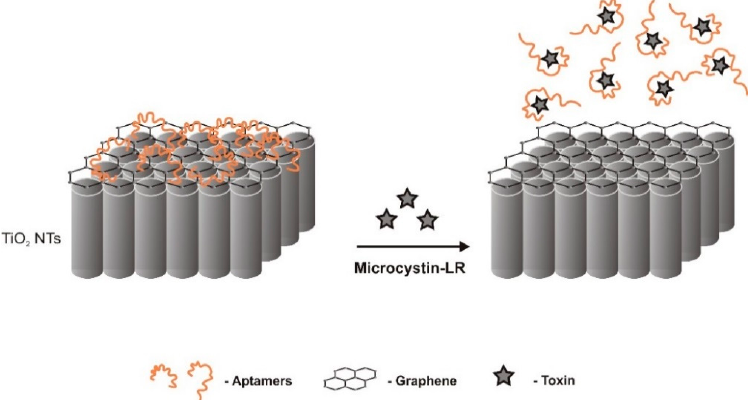
Figure 8. Label-free visible-light driven photoelectrochemical aptasensor for microcystin-LR (MC-LR) detection [52]. Aptamers are conjugated onto vertically aligned titanium dioxide nanotubes (TiO 2 NTs) photoanode substrate, functionalized with graphene, where the DNA nucleobases are adsorbed via π - π staking. In the contact of MC-LR, aptamers leave graphene sheets and lead to the increased photocurrent.